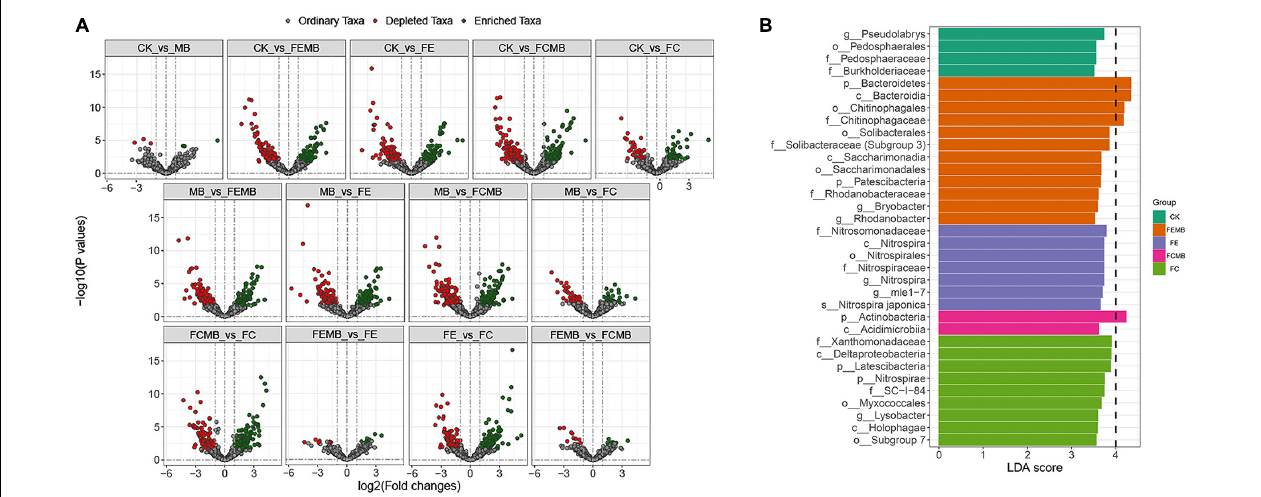
FIGURE 2 | Significance and differential analysis of bacterial communities in the soil grown with H. cordata under different fertilization regimens. (A) Volcano plots indicating differential ASV changes between different treatments. (B) Histogram of linear discriminant analysis (LDA) Effect Size (LEfSe) showing taxa with log10 (LDA scores) ≥ 3.5.